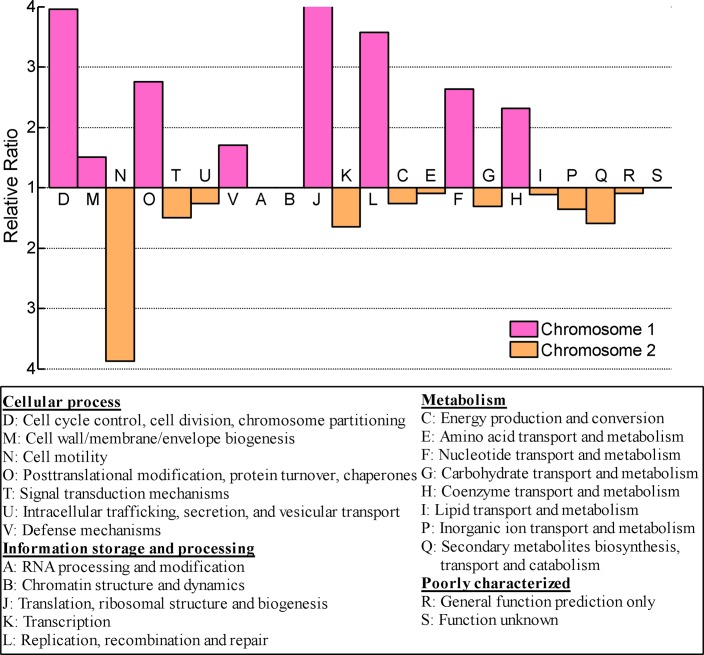
Functional distribution over two replicons based on COG classification.The scale represents the relative ratio of CDS numbers per gene source (i.e. the ratio of percentages for each class per replicon).